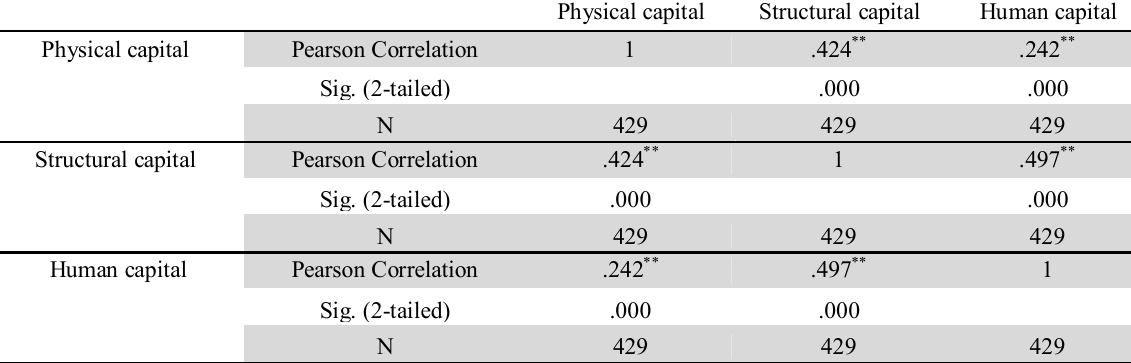
The summary Pearson correlation ratio